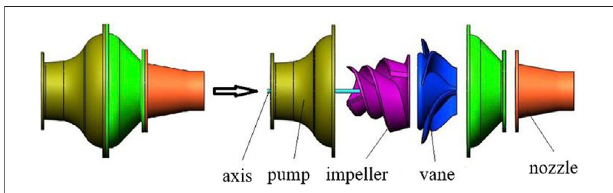
FIGURE 1 | Computational domain model diagram of fl ow through components of water jet propulsion